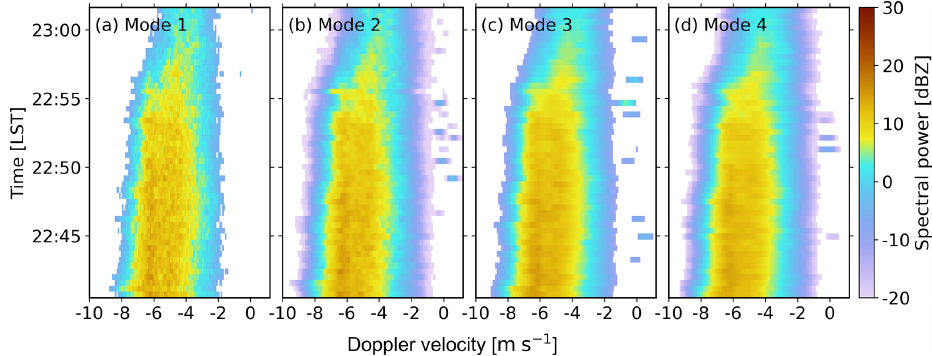
Figure 2. Time series of noise-removed Ku-band Doppler velocity spectra on 6 June 2020 from 22:40 to 23:01LST at 2.34km